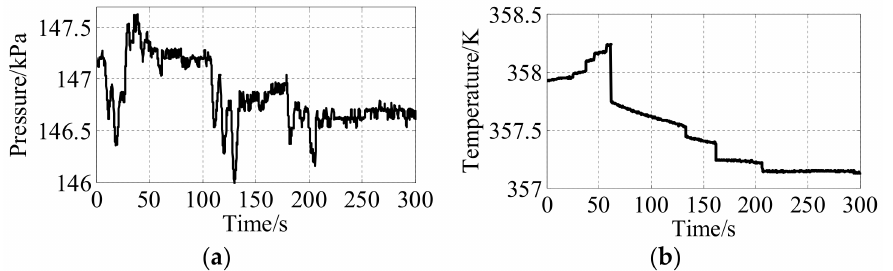
Figure 14. Inlet conditions of air source II. ( a ) Pressure conditions of air source II; ( b ) Temperature conditions of air source